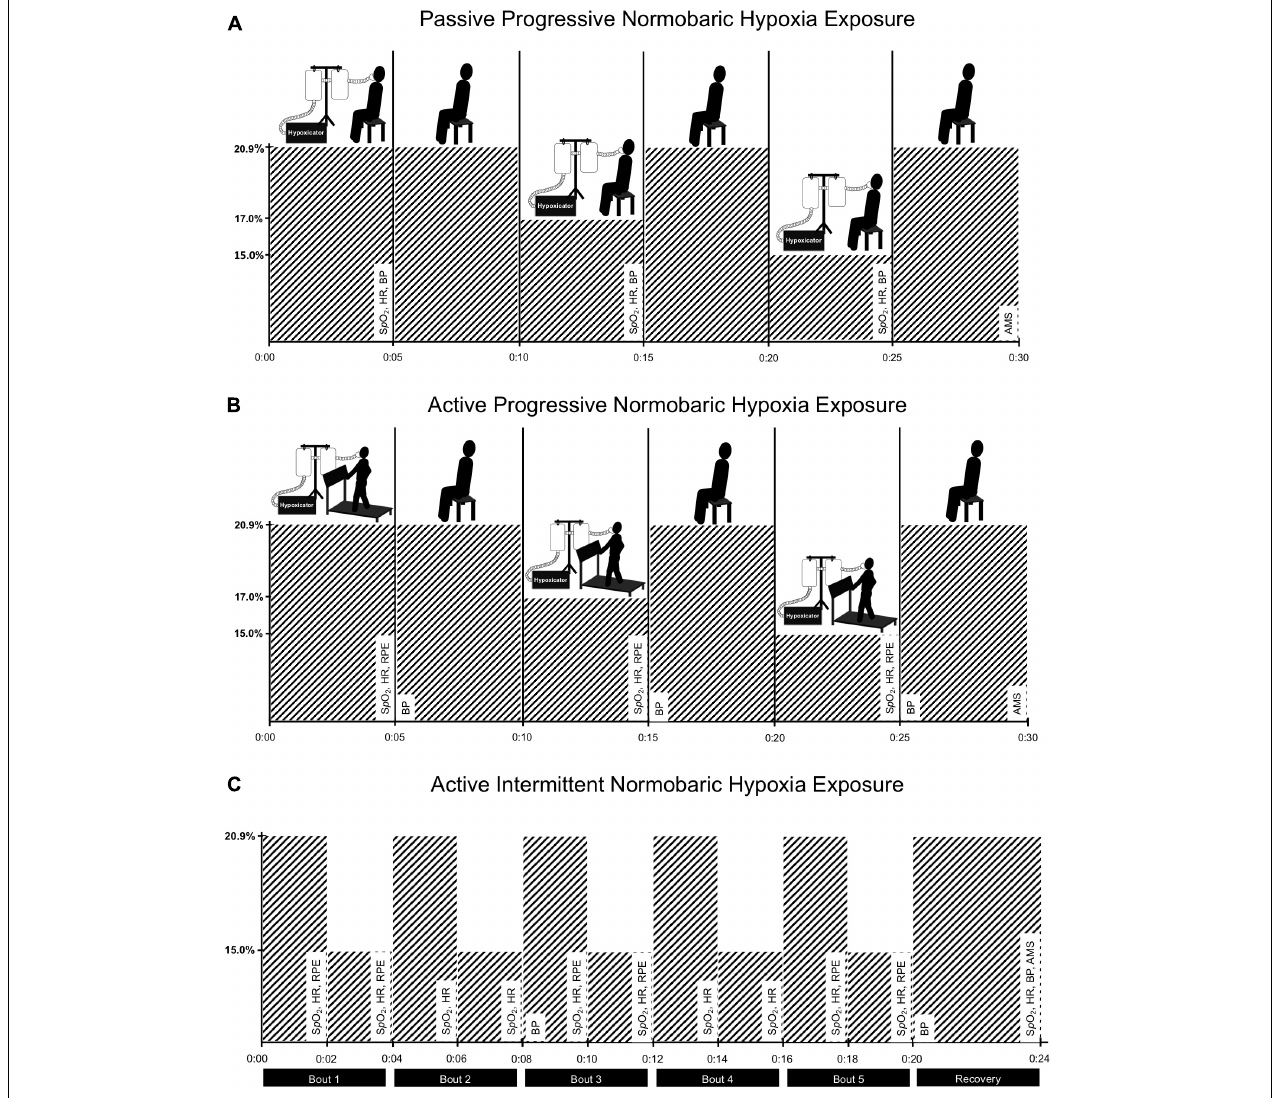
FIGURE 1 | Experimental design. To evaluate the safety and feasibility of moderate normobaric hypoxia exposure, participants were exposed to gradual reductions in the fraction of inspired oxygen (F I O 2 ) during sitting [panel (A) ] and during constant-load treadmill walking [panel (B) ]. Then, participants completed 20-min of constant-load treadmill walking while intermittently exposed to normobaric hypoxia (5 × 2-min at F I O 2 = 15.0%) interspaced with intervals of typical room air (normoxia; 5 × 2-min at F I O 2 = 20.9%) [panel (C) ]. Each pair of normobaric hypoxia and normoxia intervals were defined as a bout (5-bouts in total). Measures of blood oxygen saturation (S p O 2 ), heart rate (HR), blood pressure (BP), rating of perceived exertion (RPE), and symptoms associated with more prolong altitude exposure using the Lake Louise Acute Mountain Sickness Scale (AMS) were monitored throughout the three exposure protocols and recorded at defined intervals as indicated in the figure. A hypoxicator using nitrogen filtration technique was used to manipulate fraction of inspired oxygen in two Douglas bags. Participants were interfaced with the bags using corrugated tubing, non-breathable valve, and an oro-nasal